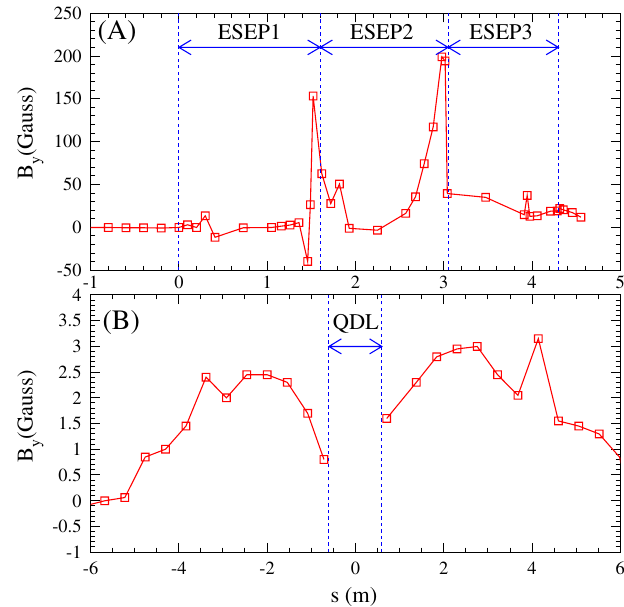
FIG. 14. (Color) Leakage field distributions from ESEP (A) and B01 (B) excited at 3 GeV measured on the surface of the vacuum ducts along the ring using a Hall probe, where the measured areas of (A) and (B) are figured by green arrows in Fig.